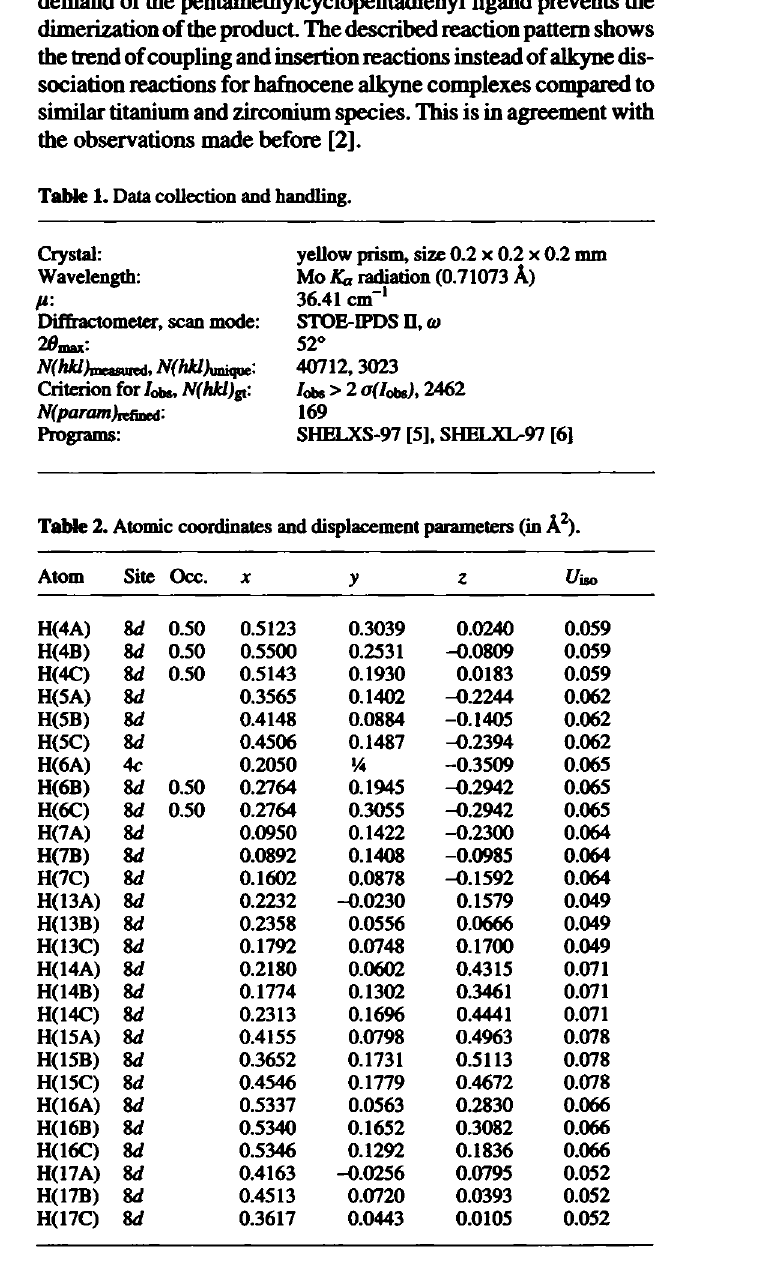
Table 1. Data collection and handling.